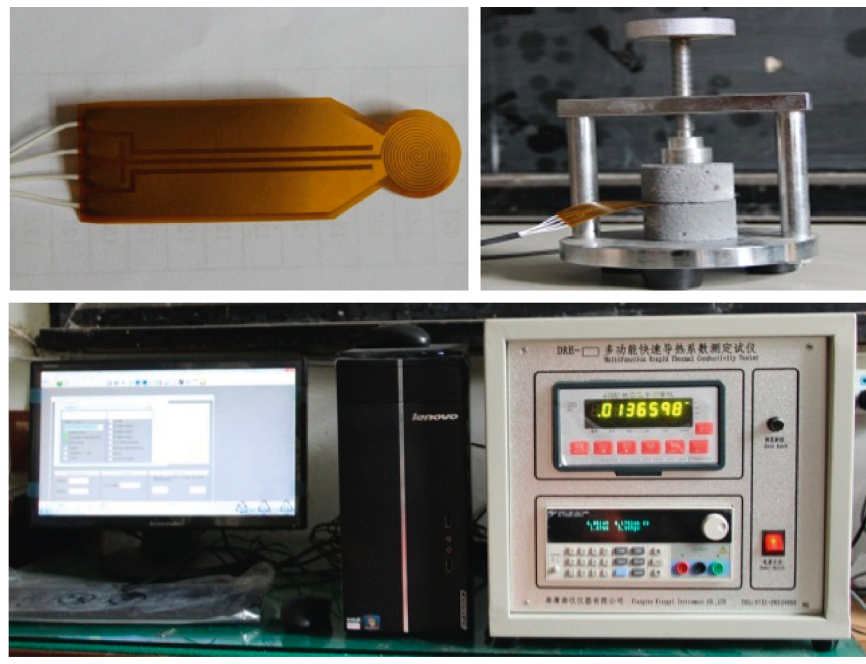
Figure 5: DRE-III heat conductivity coefficient tester and the test setup.